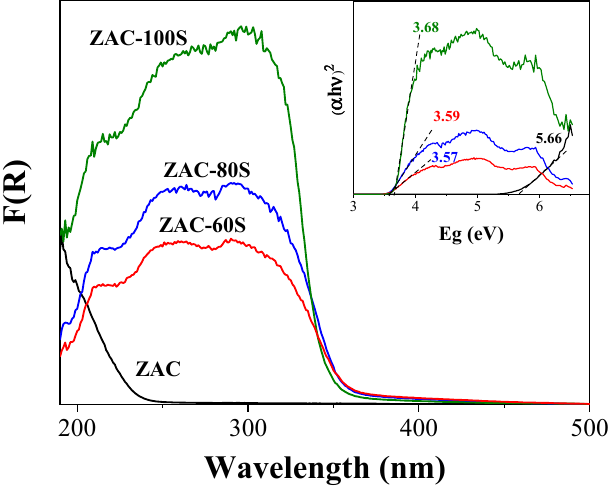
Figure 3. Diffuse reflectance spectra and band gap energy determination of the ZnAl-LHD type materials and ZAC-100S.